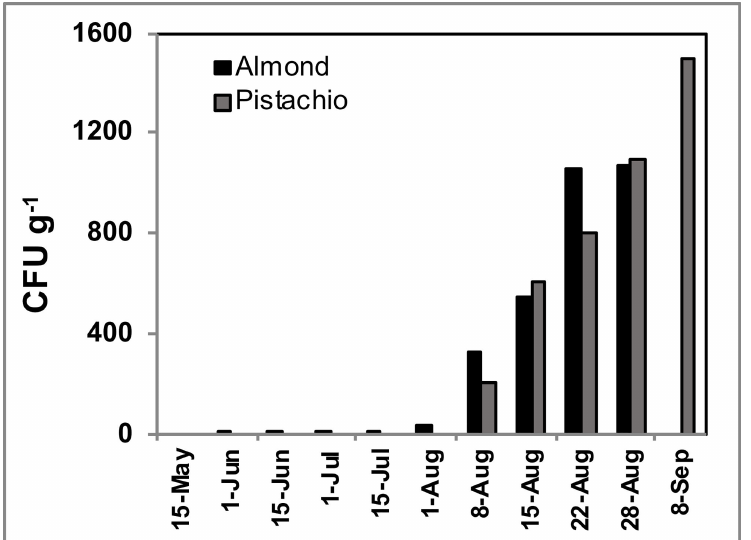
Fig 1. Fungal densities of Aspergillus spp. in almond and pistachio orchards at the Kearney Agricultural Research and Extension Center in Parlier, CA. In both crops, Aspergillus spp. fungi increase after the second week of August. Developing almond fruits were not examined in September 8 th